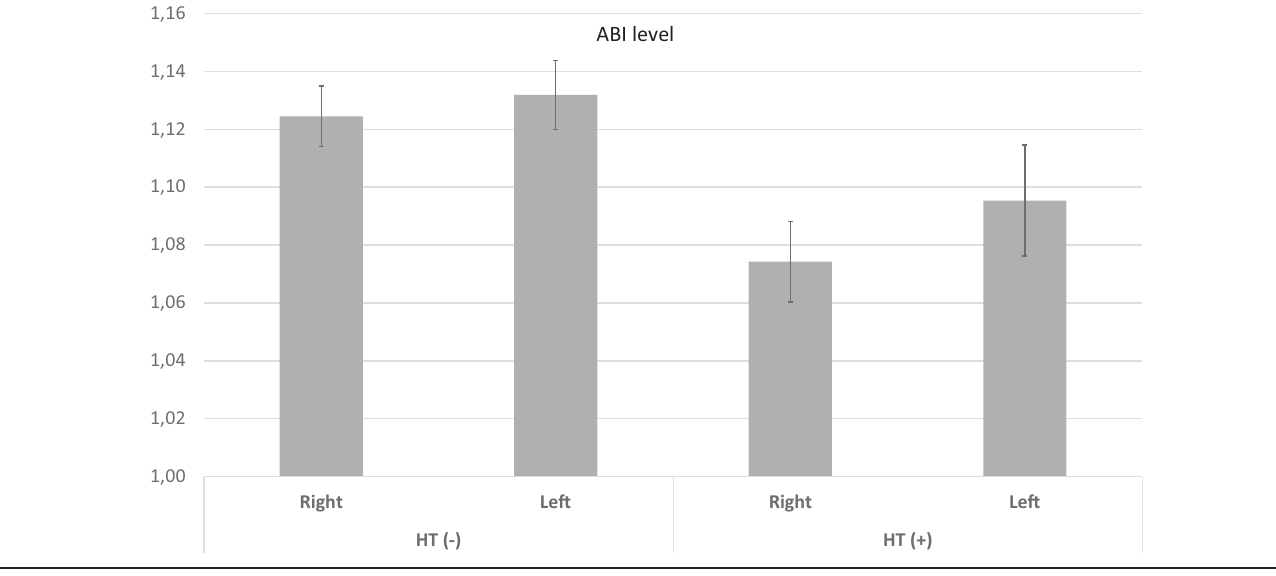
Figure 1. ABI level of the patient according to the presence or absence of hypertension.